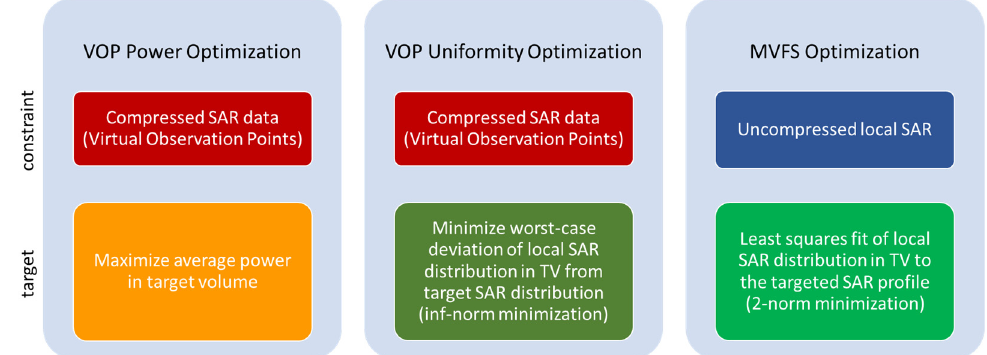
Figure 3. Common and different features of the VOP-based and multiplexed vector field shaping (MVFS)-based optimization algorithms based on the constraints and targets used to solve the op- timization problem. The targeted SAR used in this study was a uniform exposure at 100 W/kg, pushing the optimization into a high SAR plateau, as analyzed in [60].